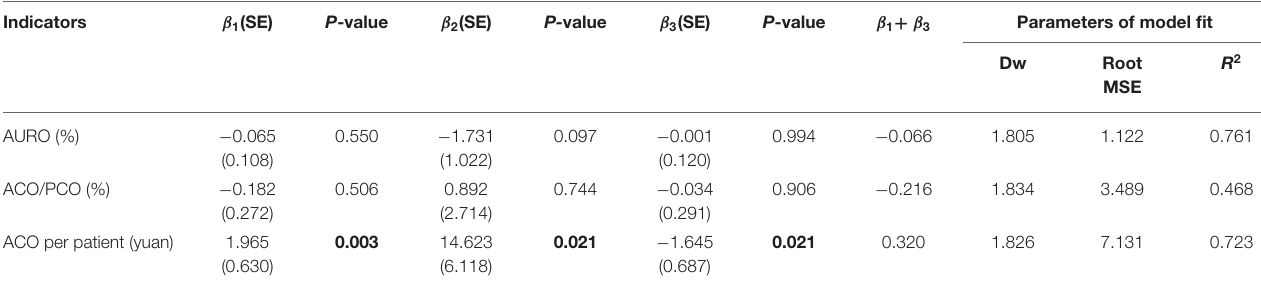
TABLE 7 | ITS analysis of antibiotic use in outpatient patient.